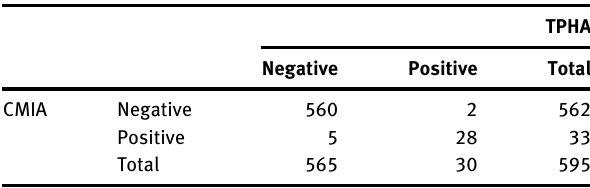
Table  : ComparisonofTPHAandchemiluminescencemicroparticle immunoassays (CMIA) test